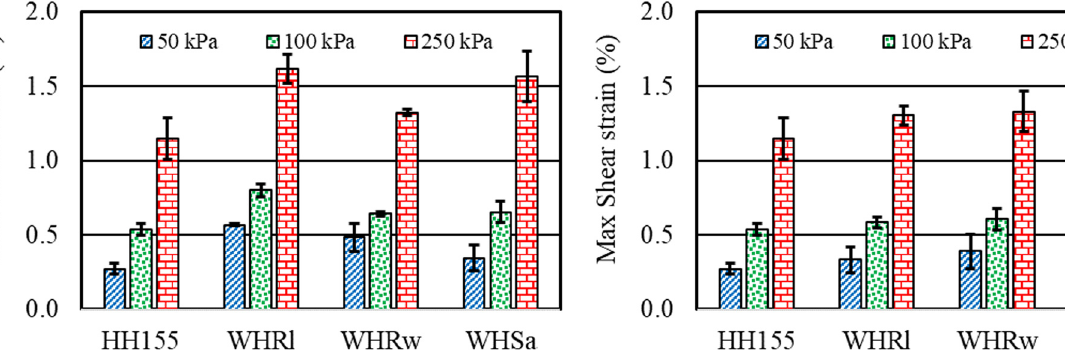
Figure 5: Maximum shear strain at each testing cycle of WMAs manufactured at 135°C.